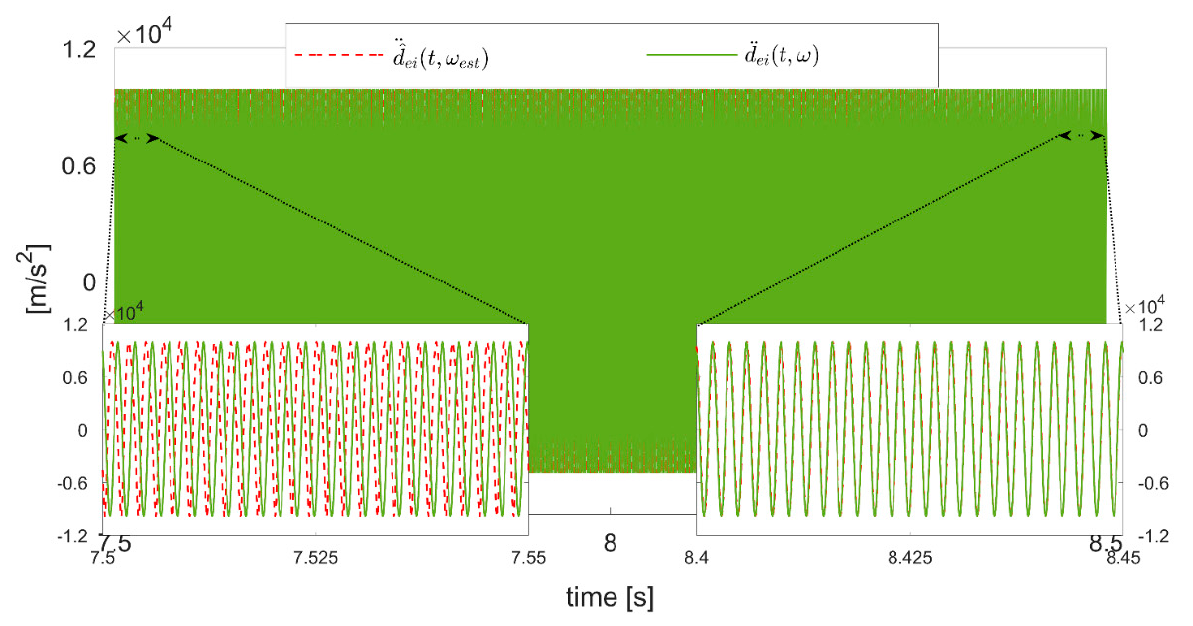
Figure 11. Hooking of the sinusoidal disturbance (cid:1856)(cid:4663) (cid:3032)(cid:3036) ((cid:1872), (cid:2033)) by its estimate of uncavitated condition with analytical disturbance ( (cid:1877) (cid:3028)(cid:3041) ) .